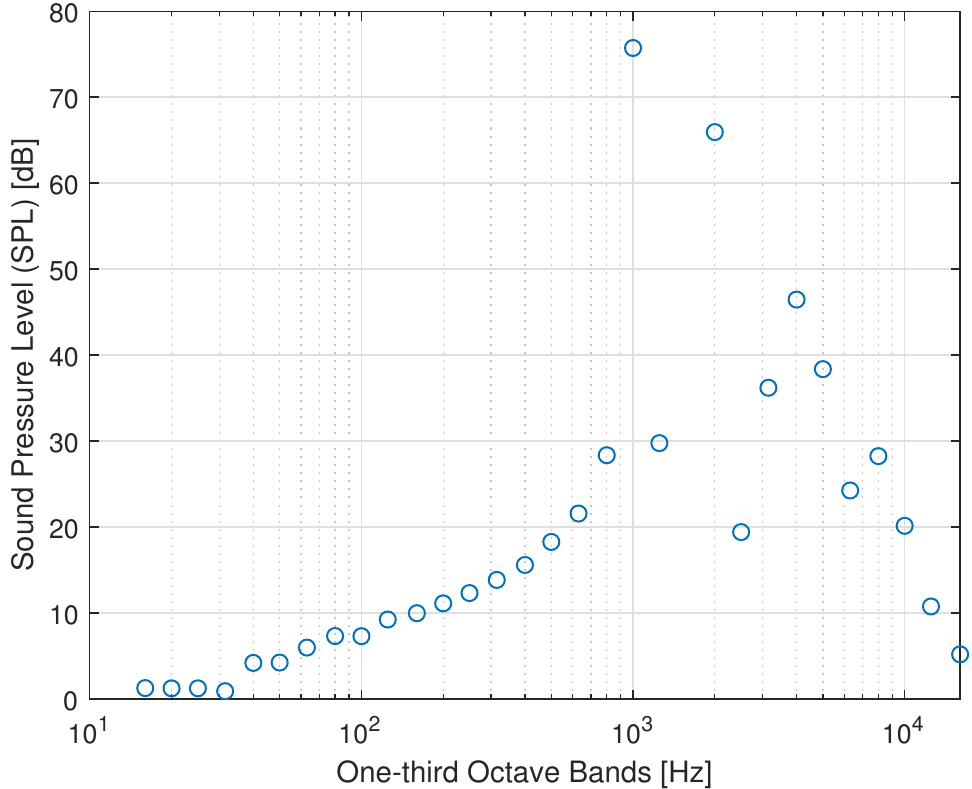
Figure 18. NLR7301 total noise one-third octave bands at azimuthal angle of 90 ◦ .